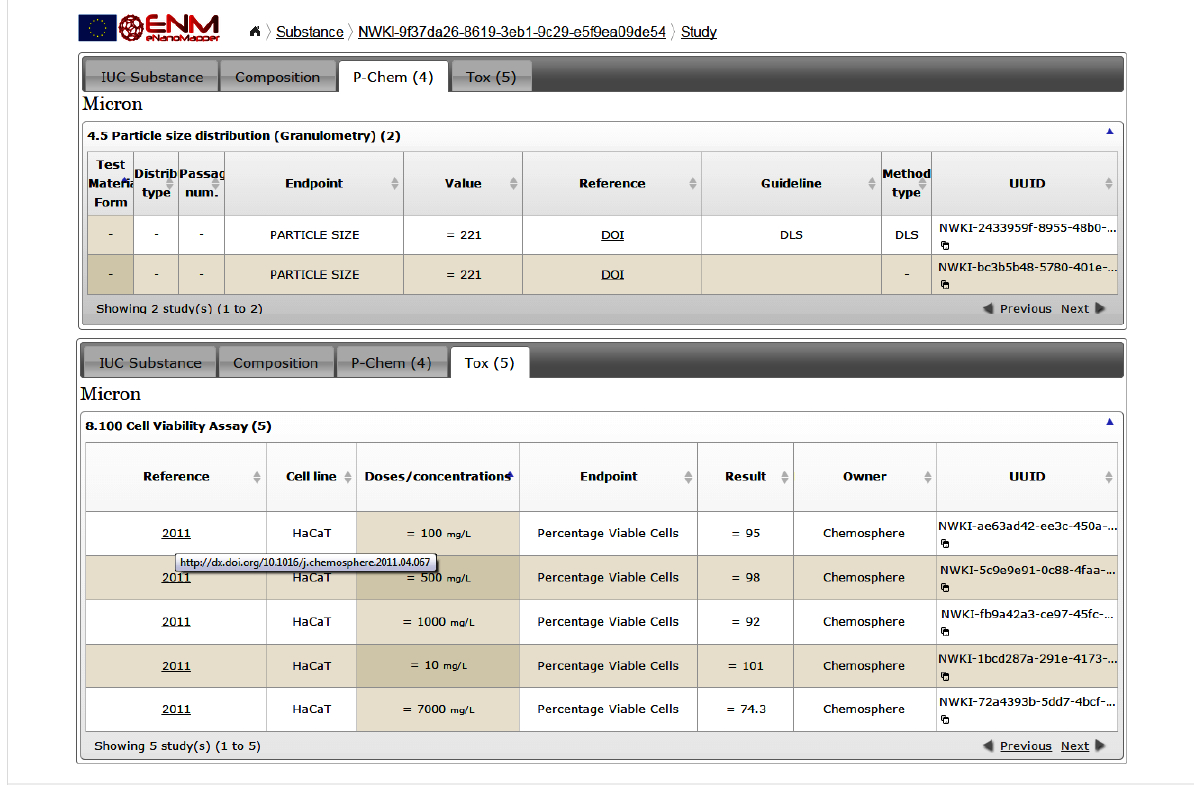
Figure 5: Physico-chemical and toxicity data from the NanoWiki data set.